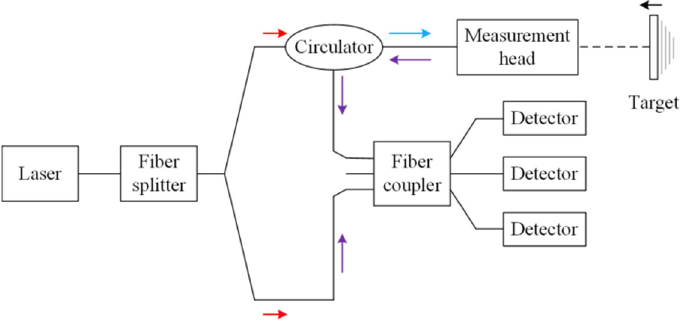
Figure 8. Schematic diagram of